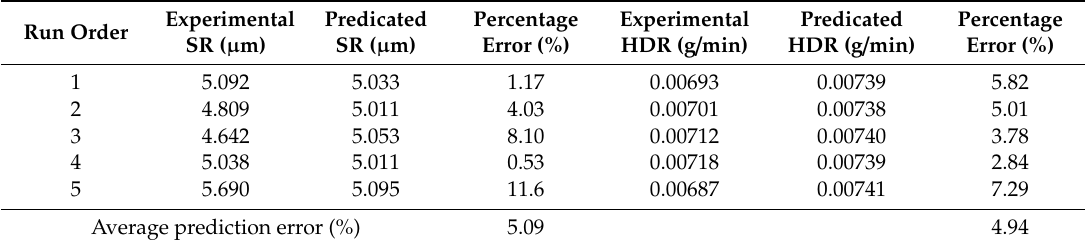
Table 10. Result comparison for predicated and experimental HDR and